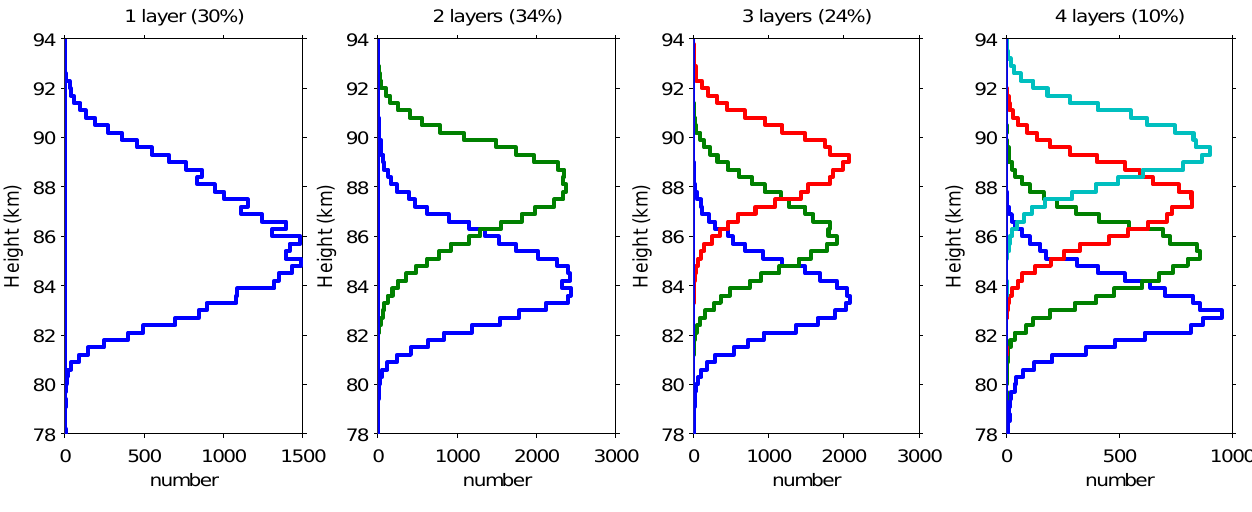
Fig. 9. For 1 to 4 layers structure occurrence (left panel to right panel, respectively): mean height dependence of the maxima of the first (blue), second (green), third (red) and forth (cyan) of all layers, averaged over five summers between 1999 and